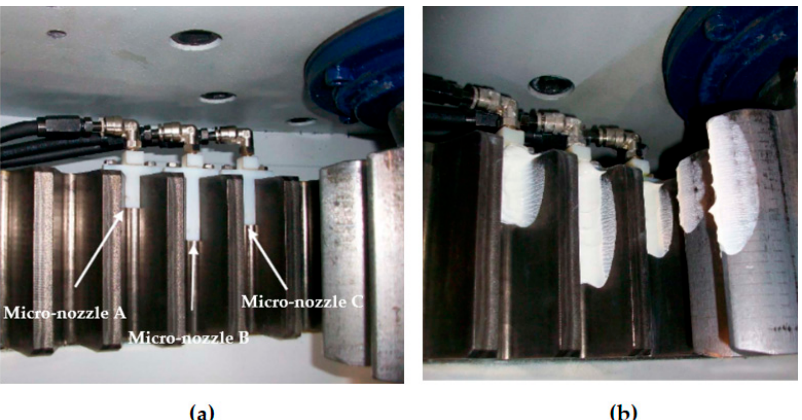
Figure 19. Micro-nozzle integration in the pitch gear, ( a ) 2, 4, and 3-cm length micro-nozzle; ( b ) Grease distribution on the tooth flank (Reprinted with permission from Ref. [173]. Copyright 2017 Springer).